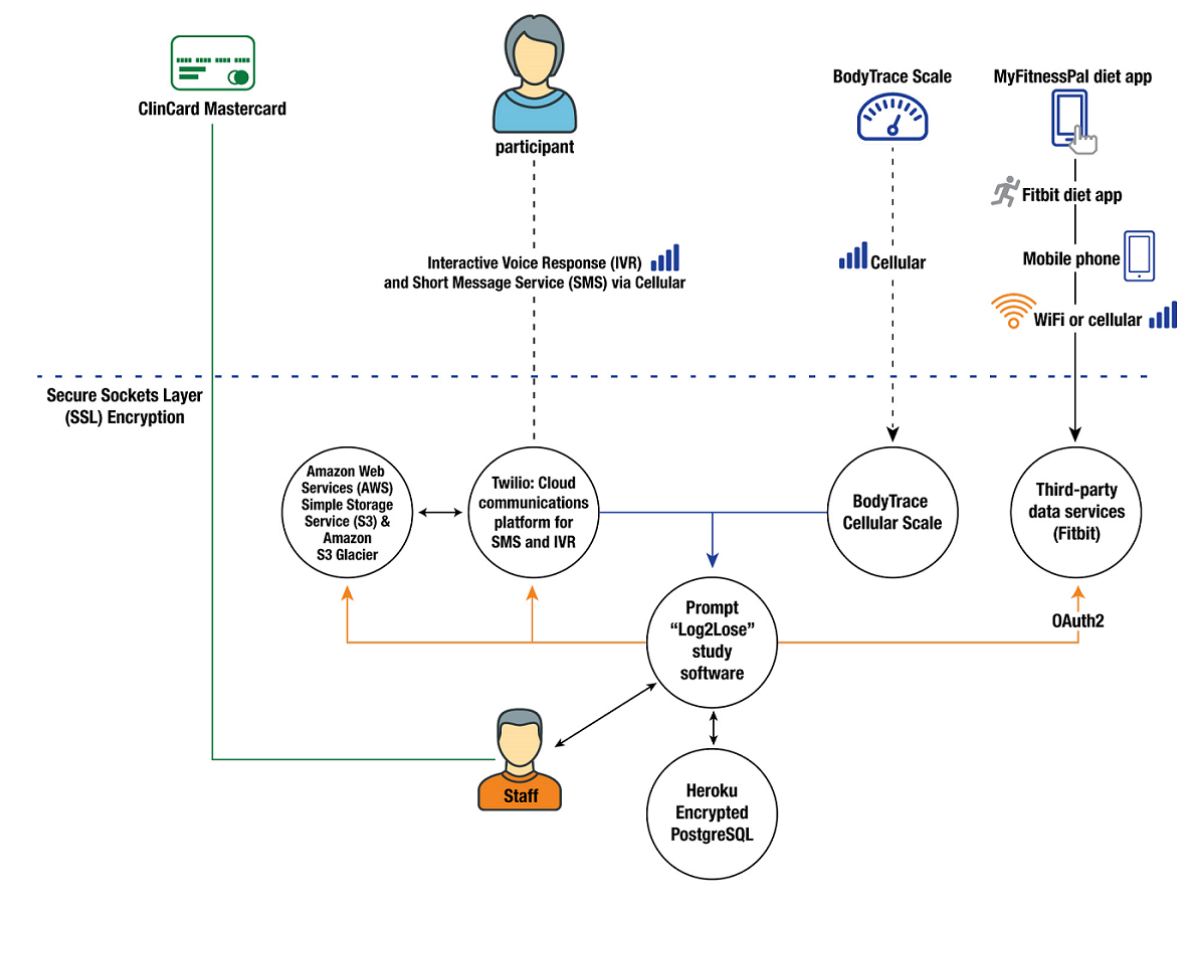
Figure 1. The custom-engineered software platform known as Prompt.